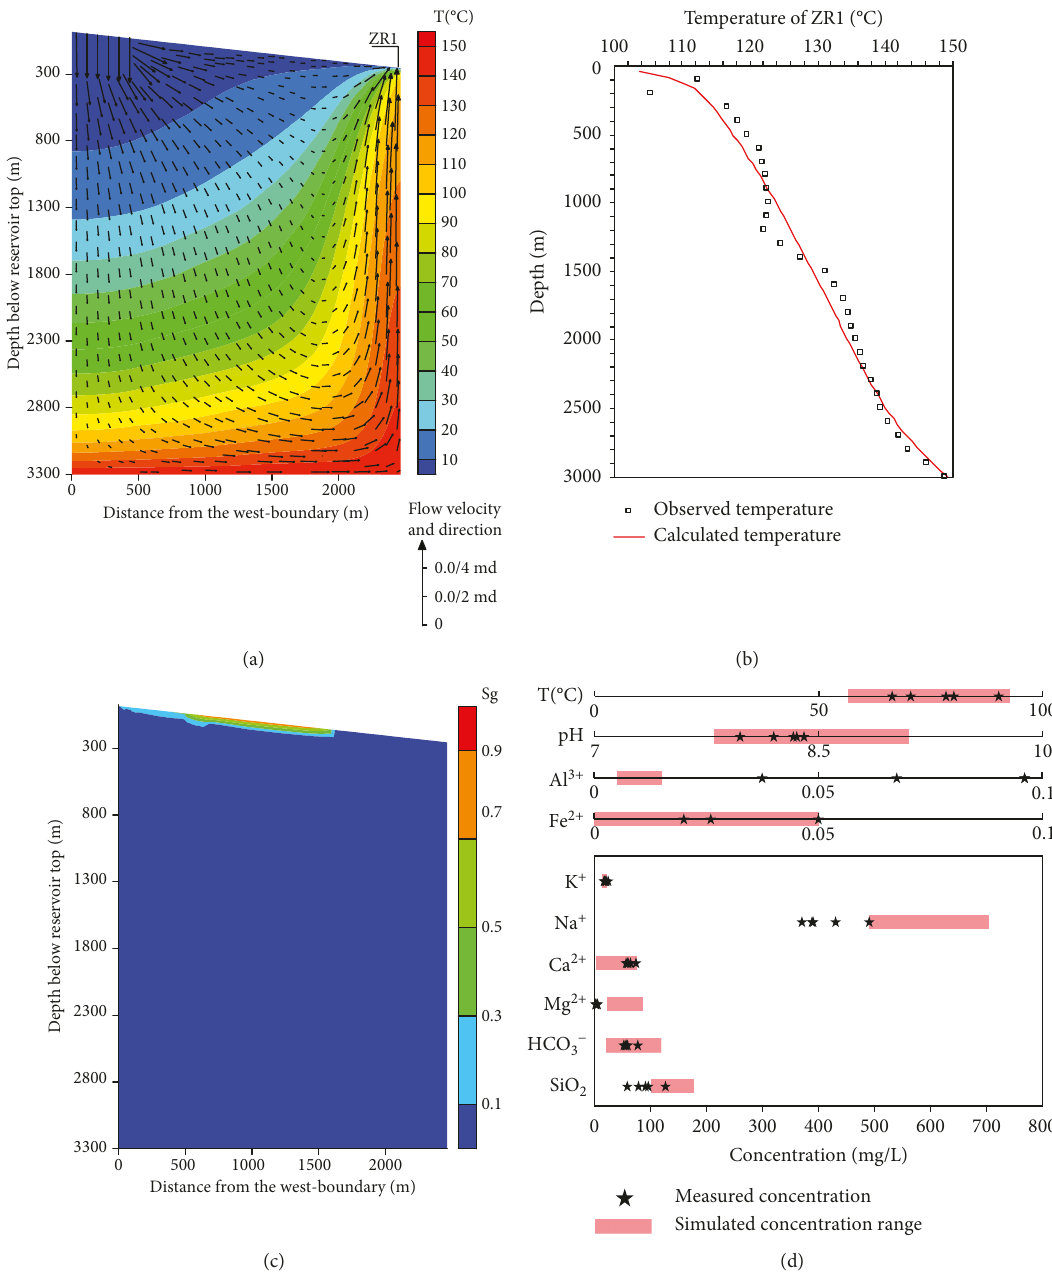
Figure 4: (a) Steady-state temperature distribution and fl uid fl ow fi eld. (b) Calculated temperatures fi t well with the observed temperatures in ZR1. (c) Gas saturation (Sg) distribution illustrates the existence of unsaturated zone at the top of the model. (d) The calculated chemical components in discharge area fi t well with observations (ZR1, G1, G2, G3, and G4). The value of “ HCO 3- ” is the sum of HCO 3- and CO 32-